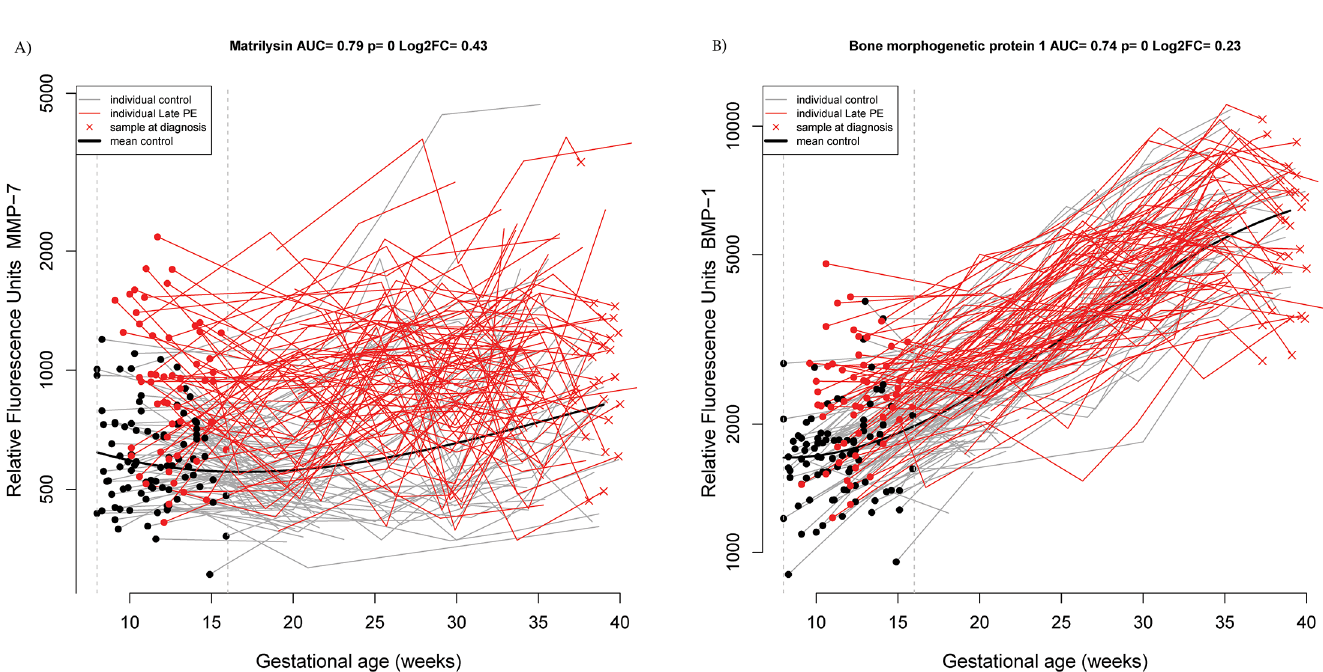
Fig 2. Longitudinal maternal plasma MMP-7 (A) and BMP − 1(B) abundance in normal pregnancy and late-onset preeclampsiacases, highlighting differences in the 8–16 weeks interval. Each line corresponds to one patient (grey = normal pregnancy, red = late-onset preeclampsia). Individual dots correspond to samples in the current gestational age interval (see vertical interruptedlines). The thick black line representsthe mean value in normalpregnancyestimated by linear mixed-effectsmodels. AUC is the area under the Receiver Operating Characteristic (ROC) curve of the protein using data in the current intervalonly; p is the nominalsignificancep-valuecomparingmean MoM values betweengroups with a moderatedt-test. Log 2 FC is the log (base 2) of the fold-change betweencases and controls, with negative values denotinglower MoM values in cases than in controls.